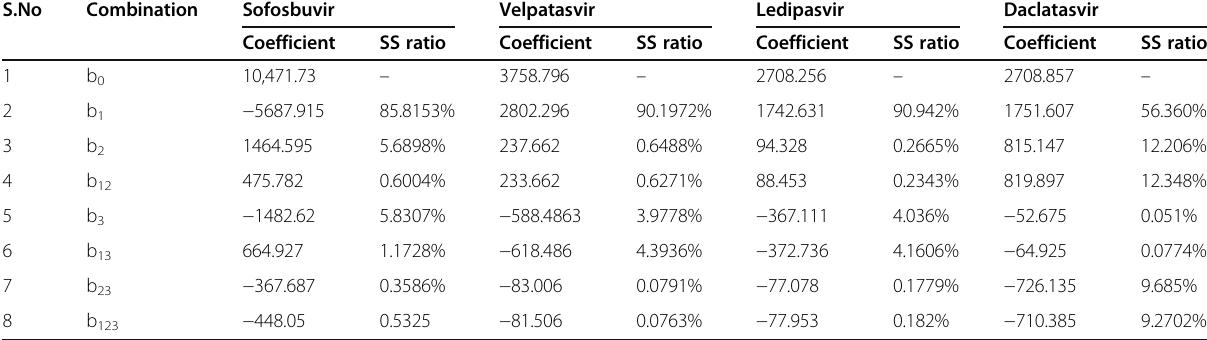
Table 3 Statistical optimization analysis of sofosbuvir, velpatasvir, ledipasvir, and daclatasvir